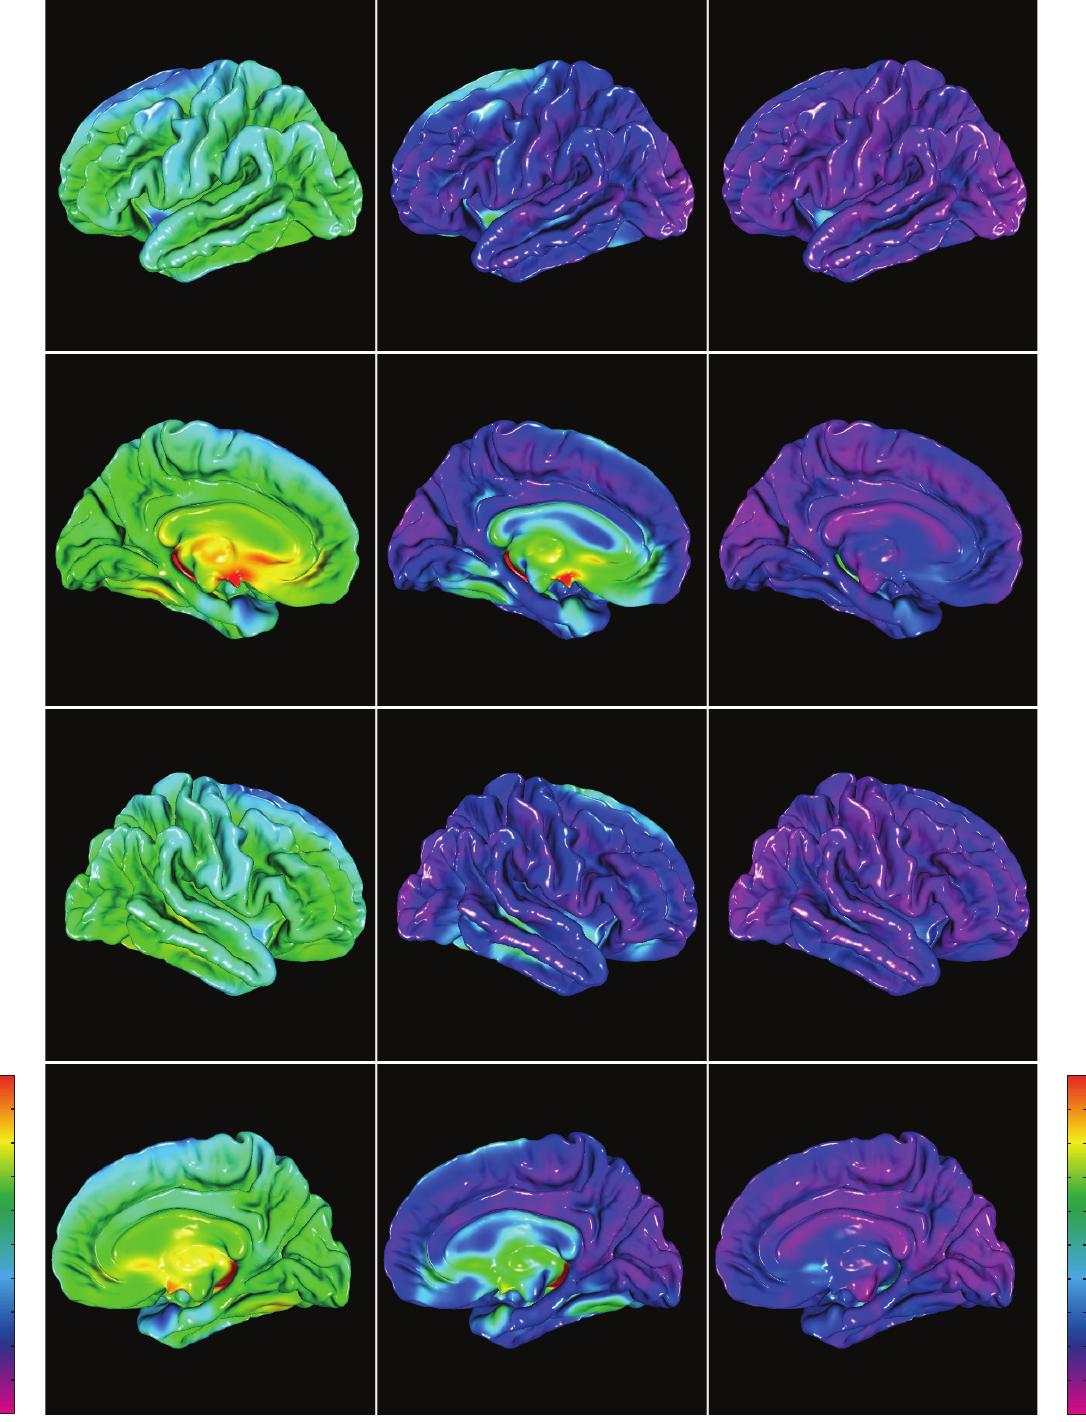
Figure 12: Group-average maps of intermethod (DELFMAP-Freesurfer) cortical thickness di ff erences, resampled to FreeSurfer’s average template (left column: signed di ff erence mean, colorbar range ± 1mm, negative/positive values mean thickness measured with DELFMAP is smaller/larger than measured with FreeSurfer, resp.; middle column: absolute di ff erence mean, colorbar range 0-1mm; right column: absolute di ff erence stdev., colorbar range 0-1mm; rows 1–4: lateral/medial surface of left/right hemisphere,